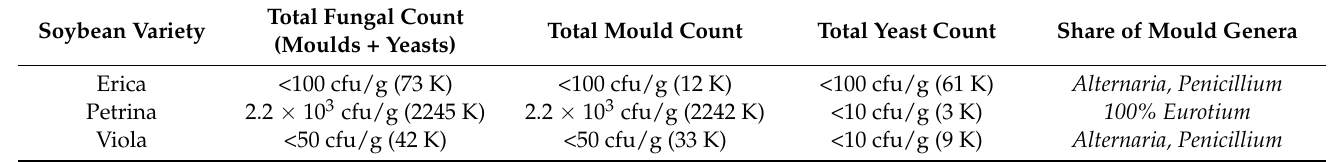
Table 2. The total count of microorganisms in the soybean seeds and the share of fungi by genus. Total Fungal Count Soybean Variety